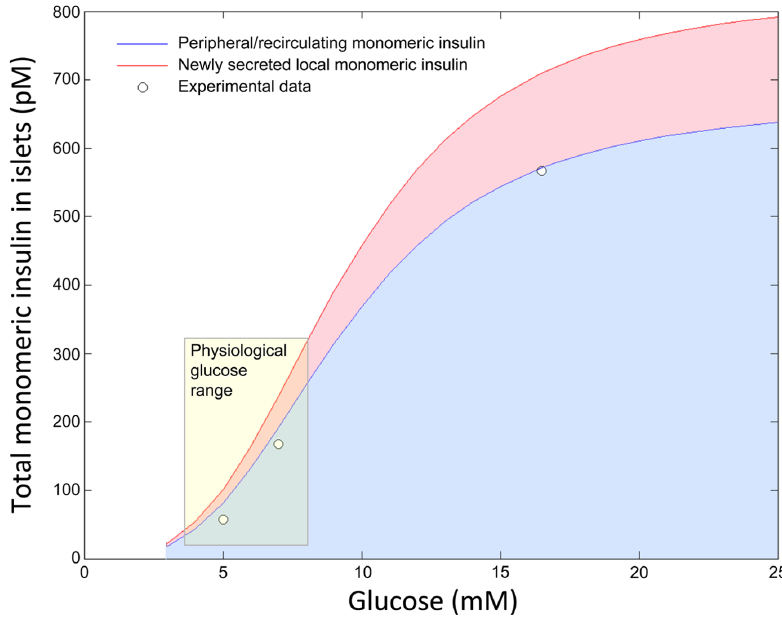
Figure 4. Total insulin monomer levels in a model islet resulting from the combination of new insulin and returning insulin. The dose-response relationship between glucose and total islet monomeric insulin. Newly released monomeric insulin (pink) plus returning peripheral monomeric insulin (blue) illustrates the total levels of monomeric insulin within islets. The white dots represent validation data from Polonsky et al 1988 ([43]).